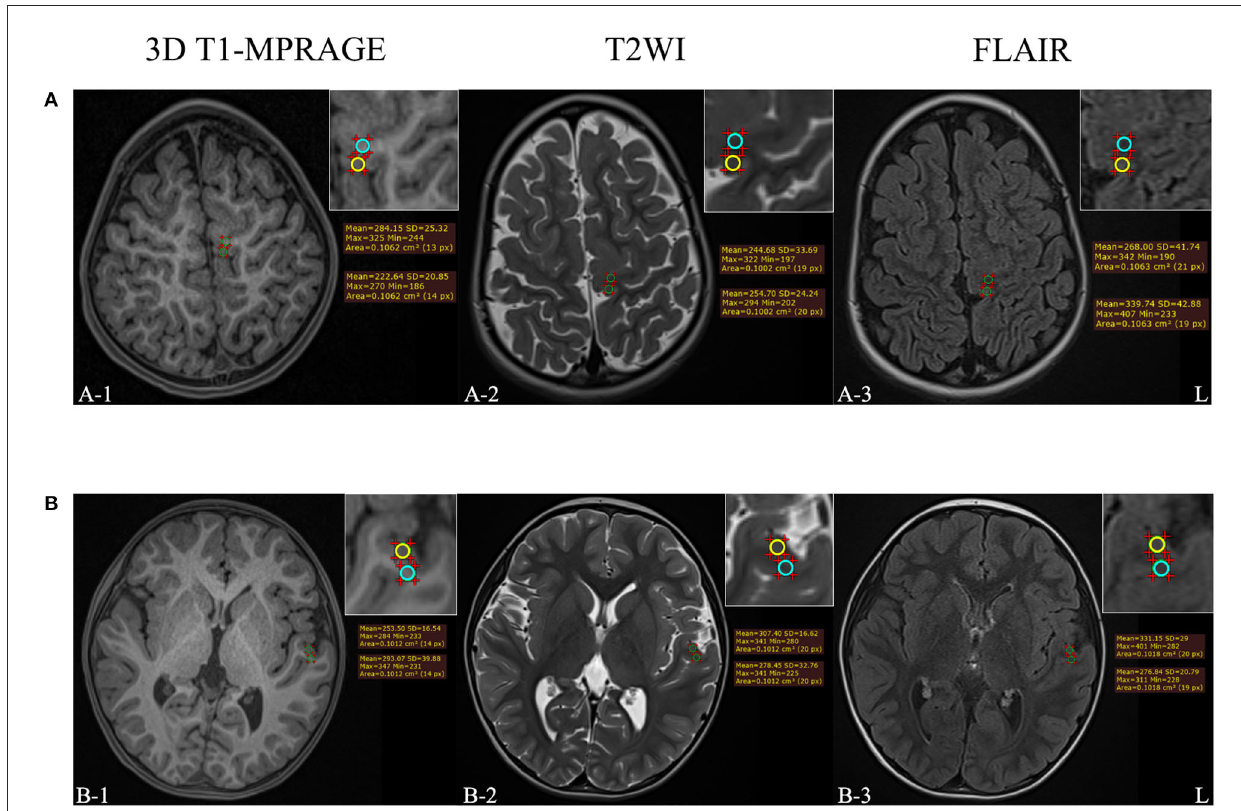
FIGURE2 (A) The example of MRI-positive images of a 3-year-old female patient who was diagnosed with FCD IIb. (B) The example of MRI-negative images of a 4-year-old male patient who was diagnosed with FCD IIa. The upper right corner of each image was a partial enlargement. The signal intensity in the gray and white matter regions of the target lesion was measured, respectively, and the yellow circle means the ROI of abnormal gray matter while the blue circle means the ROI of abnormal white